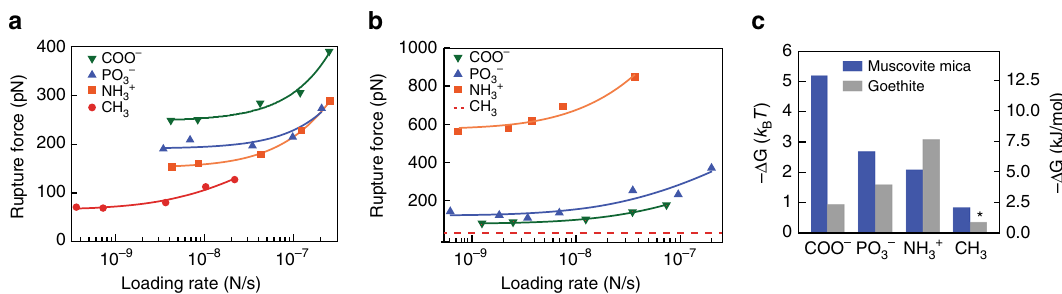
Fig. 3 Chemistry of model soil organic matter affects binding strengths to different minerals. Experiments were performed at pH 6 in 10 mM NaCl. a , b Mean rupture forces for interactions between self-assembled monolayers with various functional groups and a muscovite mica or b goethite. c Experimentally derived values for the binding free energy ( Δ G b ) from fi tted dynamic force spectroscopy data. Values for fi tting parameters can be found in Supplementary Table 1. Asterisk : The value for the methyl group interacting with goethite is approximate, as the force was close to the detection limit of the